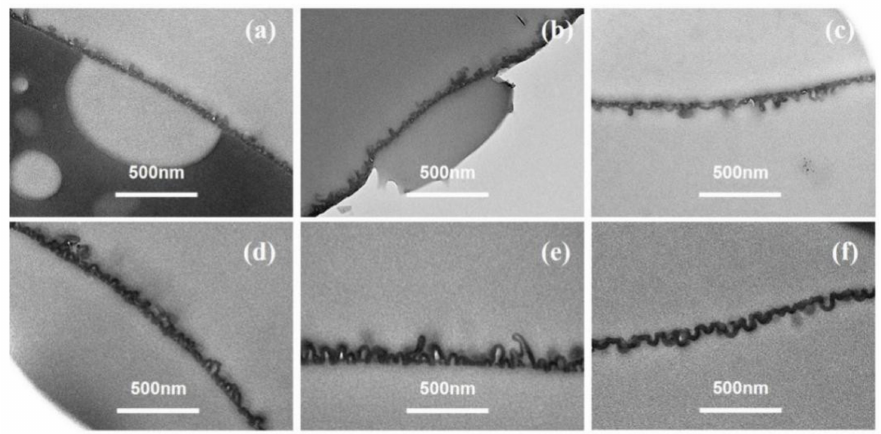
Figure 3. TEM image of PA’s cross-section in series1. ( a – f ): TFC − 1~TFC − 6.